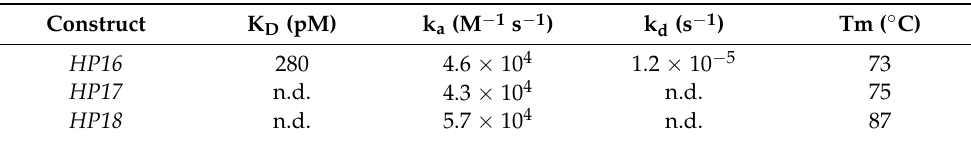
Figure 3. Surface plasmon resonance (SPR) sensorgrams of single-cycle kinetic titration of HP16 , HP17 , and HP18 binding to immobilized Z HER2:342 -SR- HP15 . Each PNA probe was injected at concentrations of 22.6, 45.3, 90.6, 181.25, and 362.5 nM. Table 2. Kinetic parameters and melting temperatures for the secondary PNA probes HP16 , HP17 , and HP18 binding to Z HER2:342 -SR- HP15 .